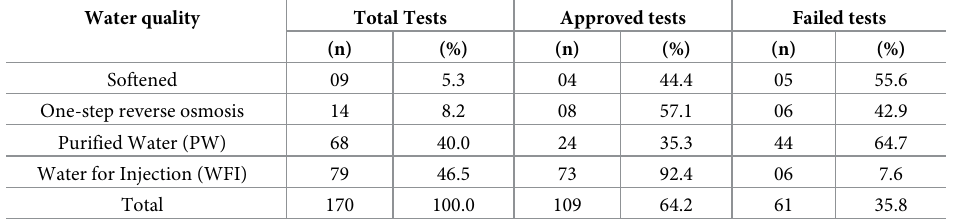
Table 2. Non-condensable gases concentration tests performed, approved, or failed tests (%) based on the type of water used for steam generation, from September/16 to